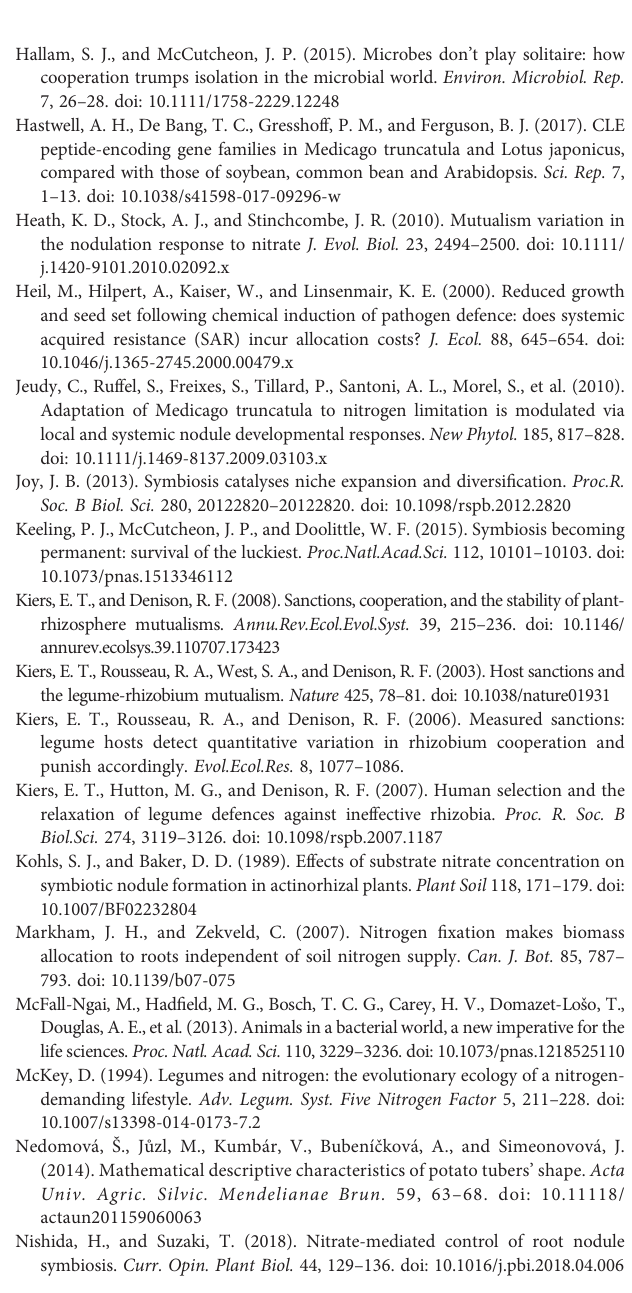
FIGURE S1 | Expression pro fi le of P. andersonii CLE peptide encoding gene. Expression pro fi le of P. andersonii CLE genes in non inoculated roots, nodule promordia and inoculated roots under low (0.5 mM KNO 3 ) and high nitrate (5.0 mM KNO 3 ) conditions. Expression is given in DESeq2-normalized read counts; error bars represent SE of three biological replicates. Dots represent individual expression